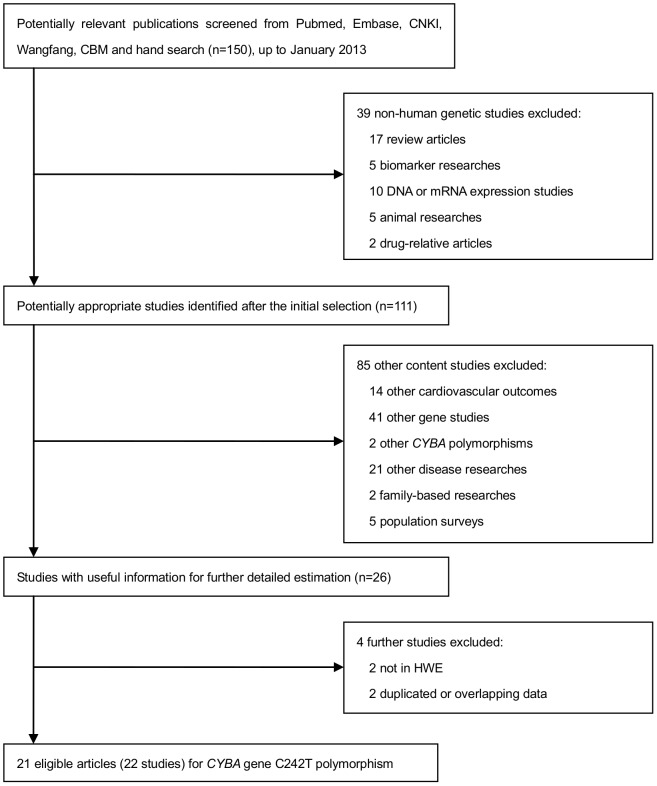
Flow diagram of search strategy and study selection for meta-analysis.